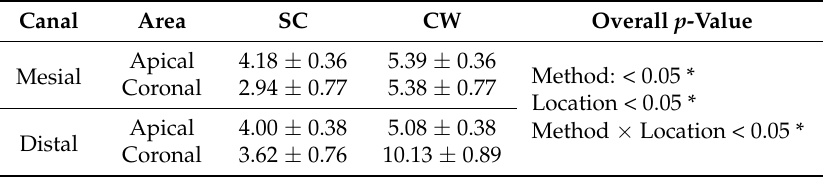
Table 2. The percentage of voids inside the filling material (V in ).